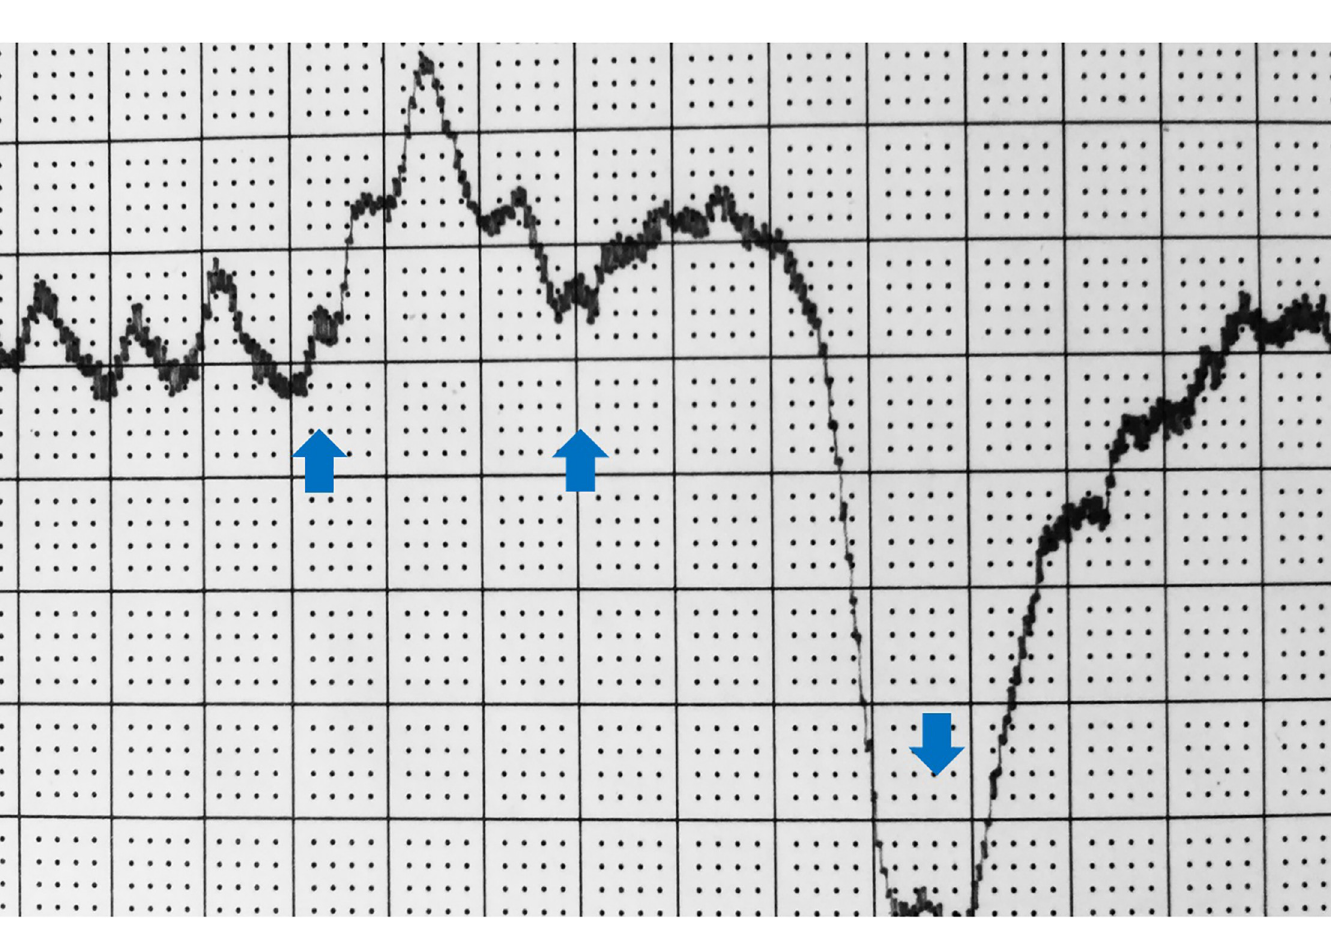
Fig 2. The big toe arterial pulse recording during arterial pump support. First arrow at inflation time of chamber 1 (fore-foot), second of chamber 2 (mid-calf) and third deflation of both chambers. Note increase in pulse amplitude immediately after chambers inflation due to a 4–6 sec toe arterial dilatation, before chamber pressure reaches 120mmHg causing a 2 sec drop due to stop of arterial